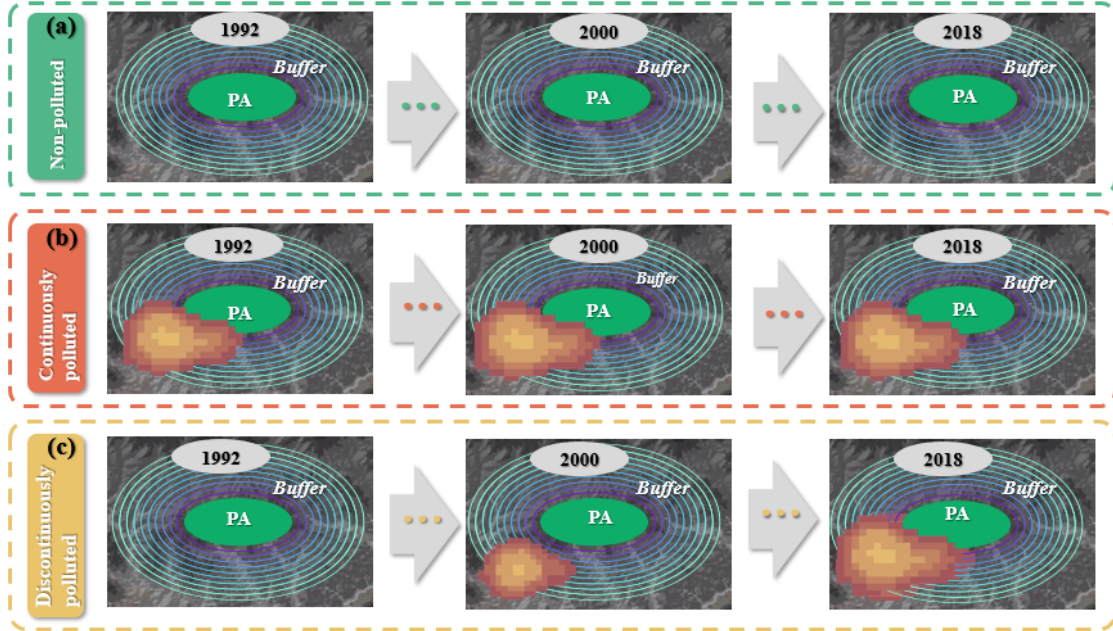
Figure 2. Conceptual illustration of light pollution categories of non-polluted ( a ), continuously polluted ( b ), and discontinuously polluted ( c ).